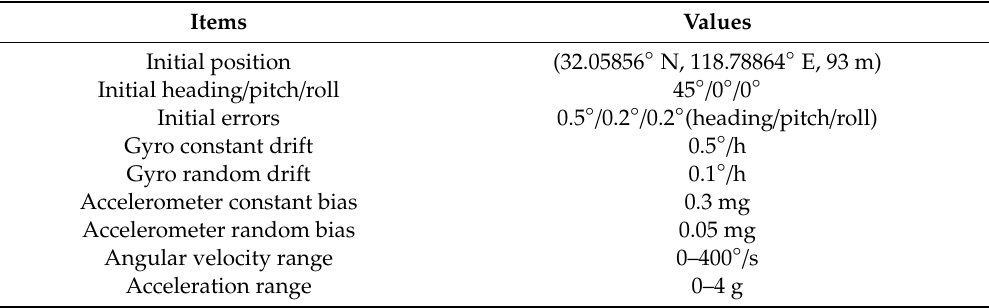
Figure 4. Schematic diagram for the experiment and simulation. Table 1. Initial parameters in the simulation.